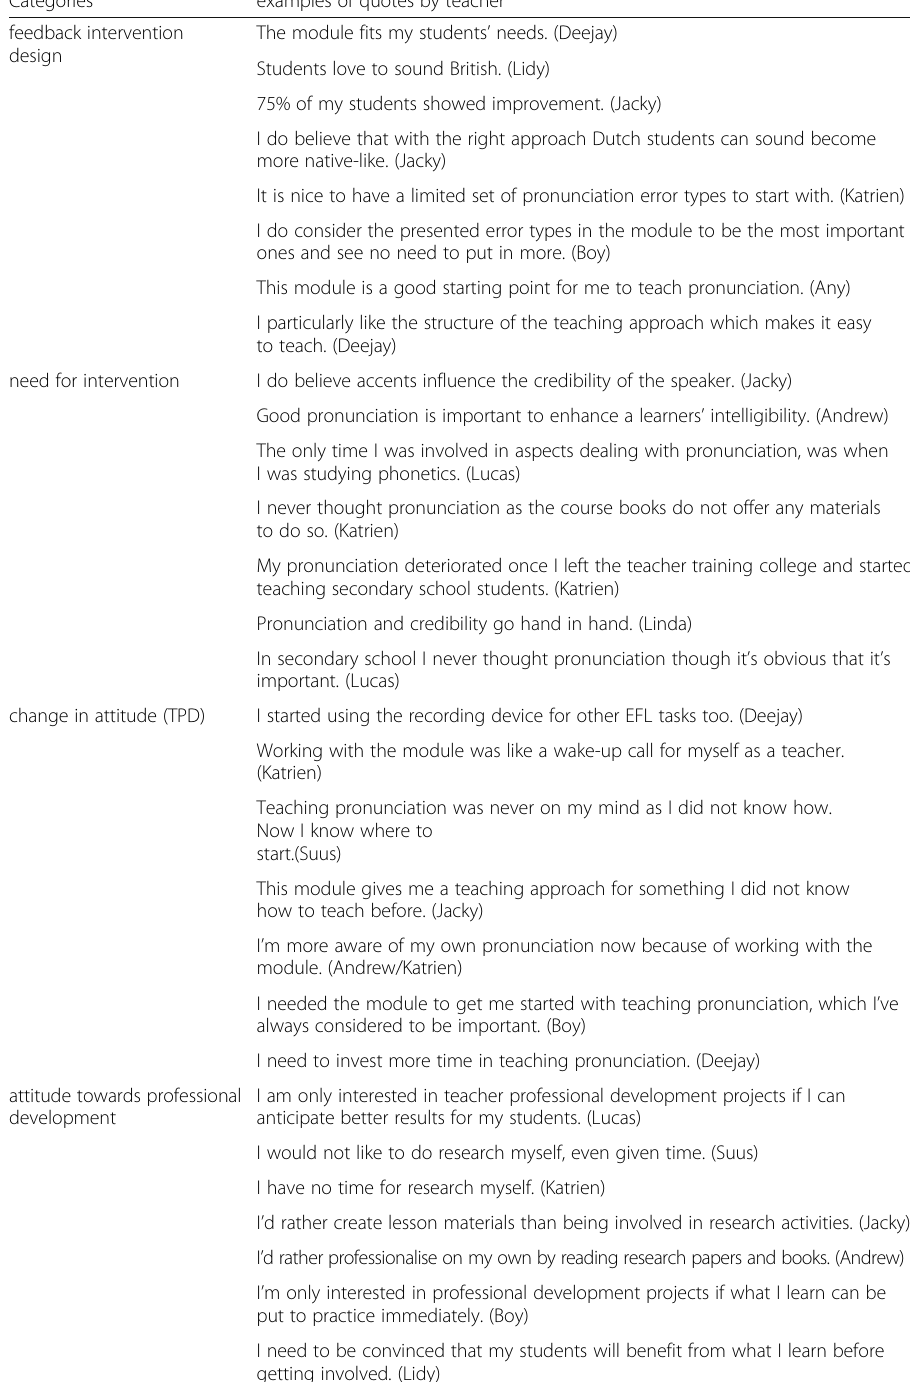
Table 4 Categories as sensitizing concepts based on research questions test in phase one Categories examples of quotes by teacher feedback intervention